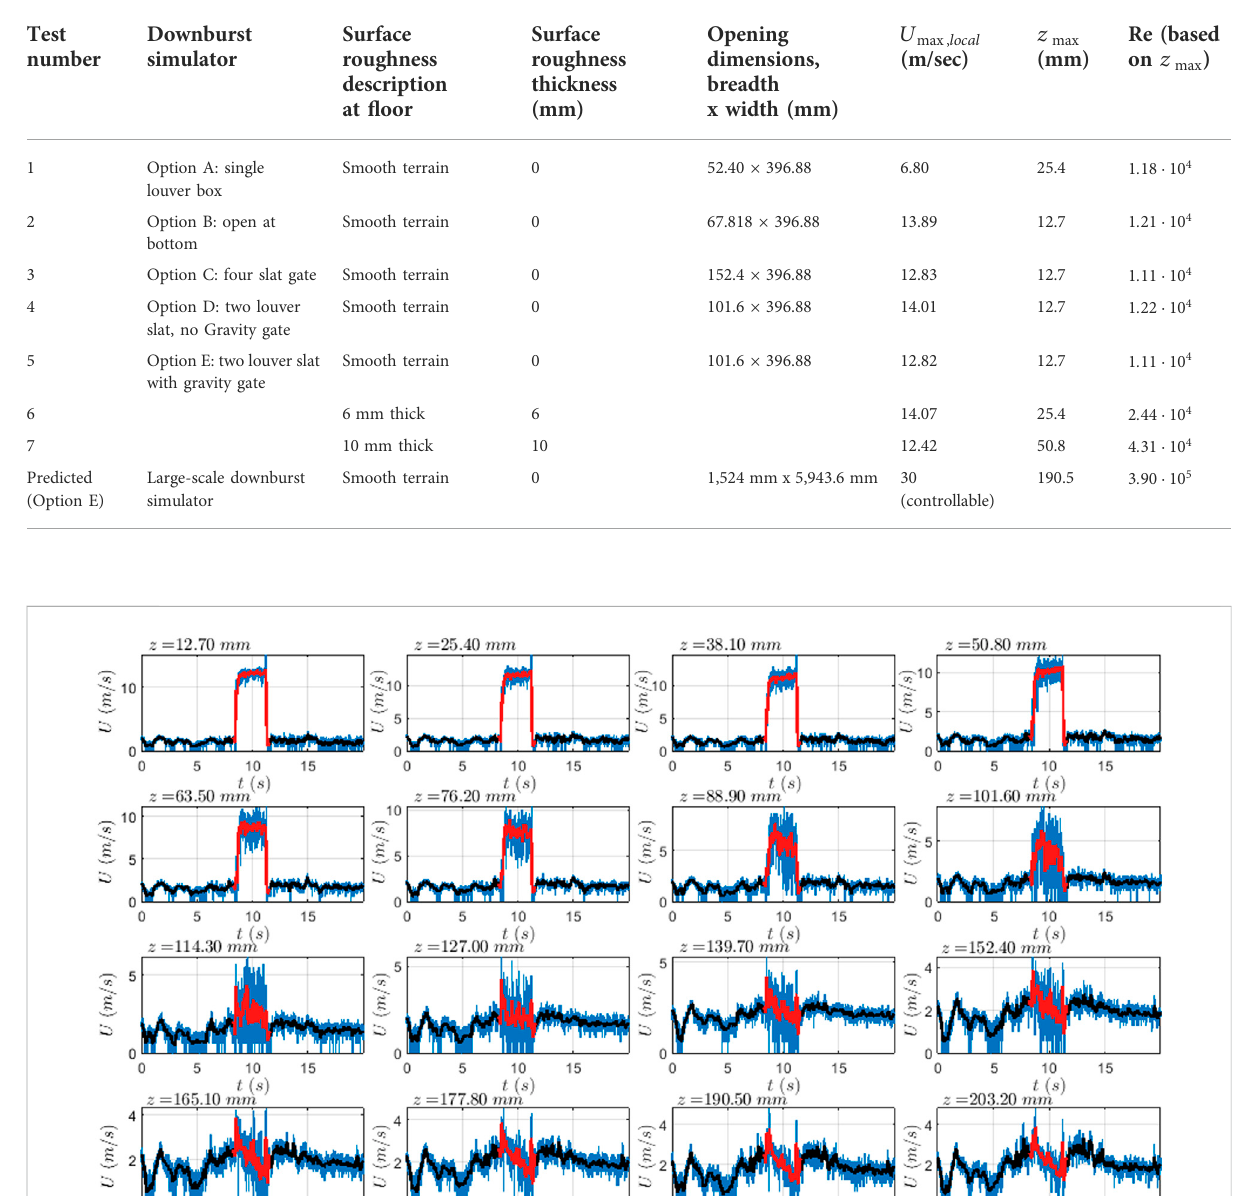
TABLE 2 Small-scale downburst test con fi gurations at the WOW TTC.